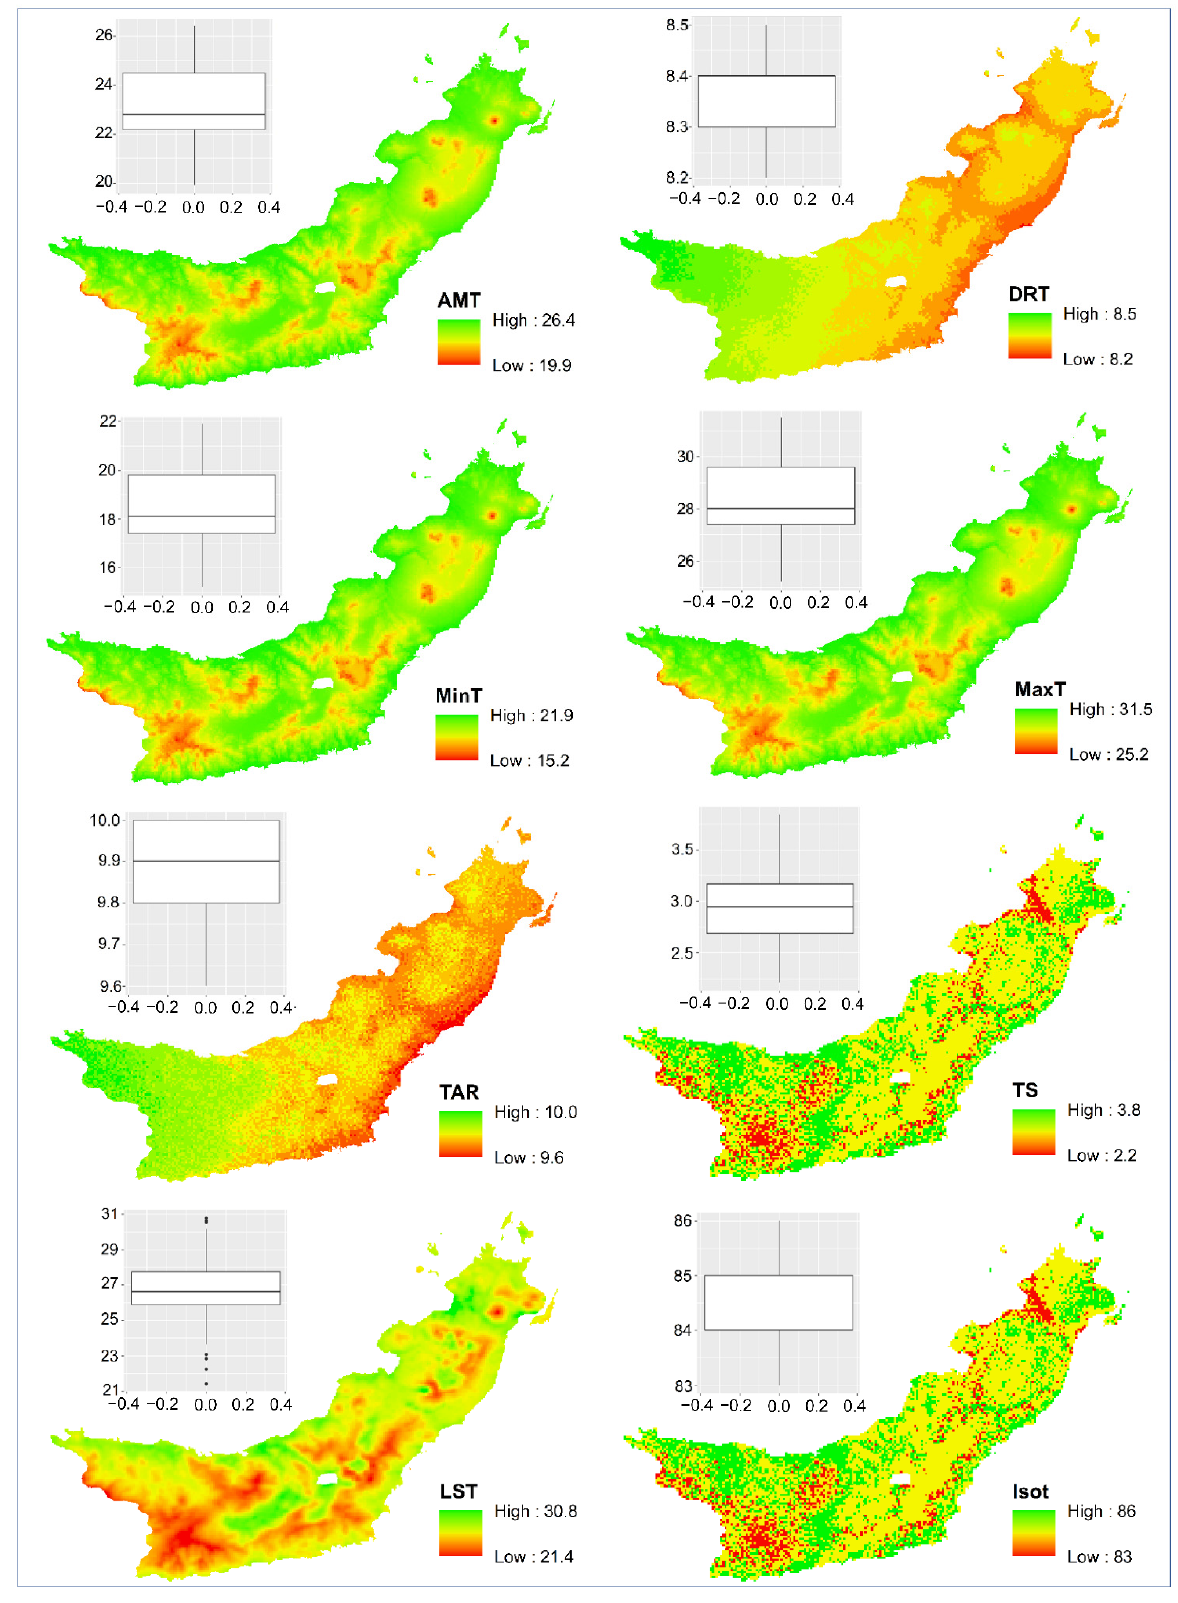
Figure 3. Temperature indicator images for Magnolia spp. in North Sulawesi.